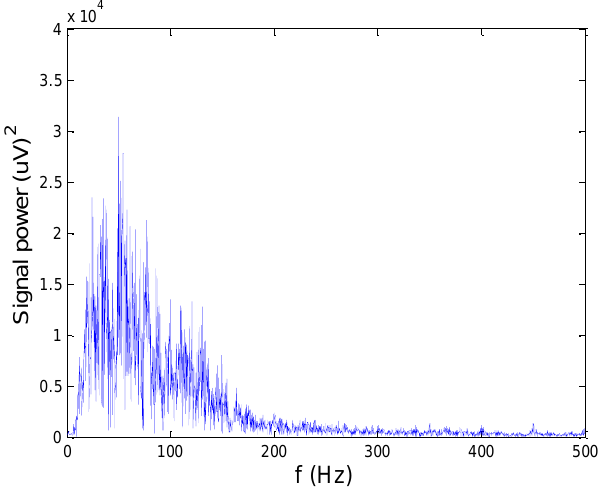
Figure 16. Frequency spectrum of signal filtered by wavelet method shown in Figure